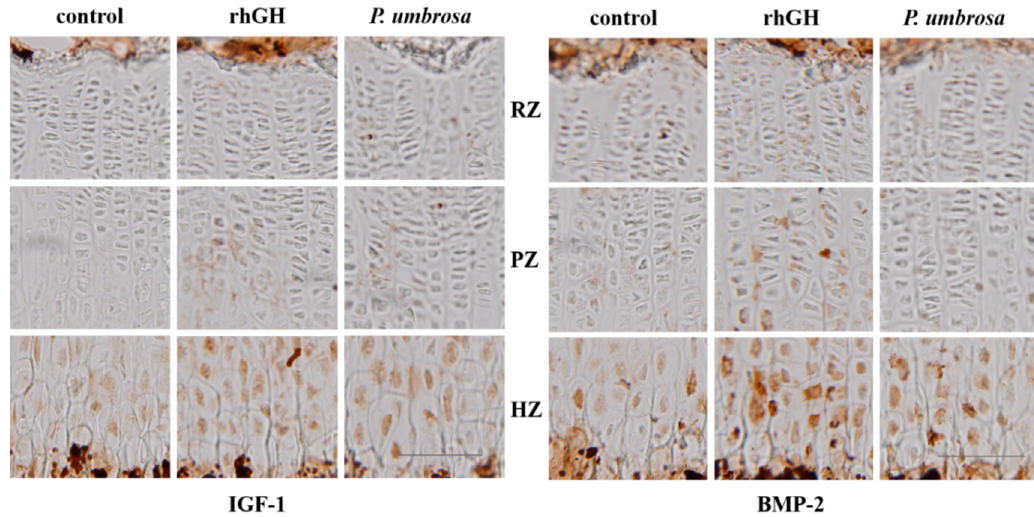
Figure 5. Immunohistochemical localization of insulin-like growth factor-1 and bone morphogenetic protein-2 on the proximal tibial growth plate in rats, control: vehicle treated control group, rhGH: rhGH 200 μ g/kg (s.c.) treated group, P. umbrosa : P. umbrosa 300 mg/kg (p.o.) treated group, RZ: resting zone, PZ: proliferative zone, HZ: hypertrophic zone. The scale bar is 100 μ m.